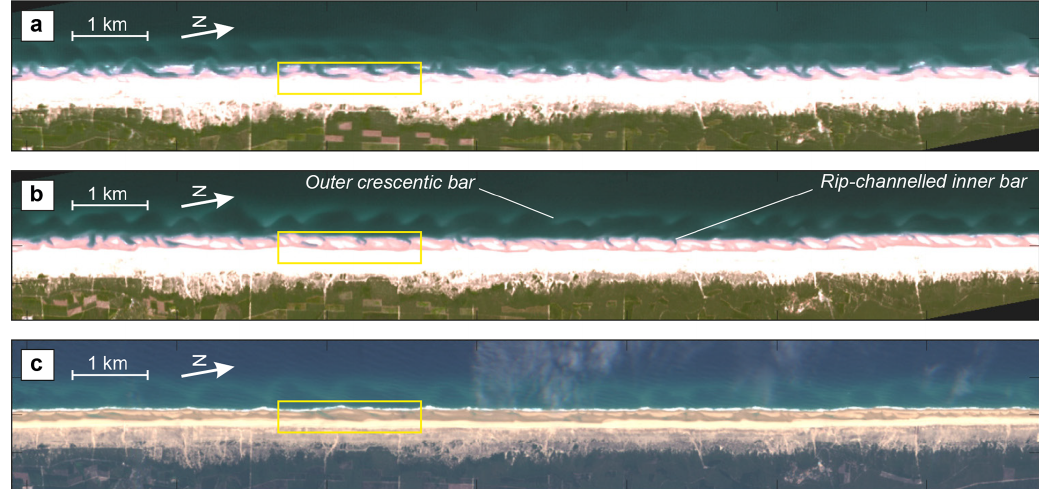
Figure 16. Satellite images of the Gironde coast around low tide near the vicinity of Truc Vert beach with the survey area in Fig. 15a indicated by the yellow box: (a) SPOT 5 image on 18 June 2007, (b) SPOT 5 image on 24 June 2009, and (c) Sentinel-2 image on 24 September